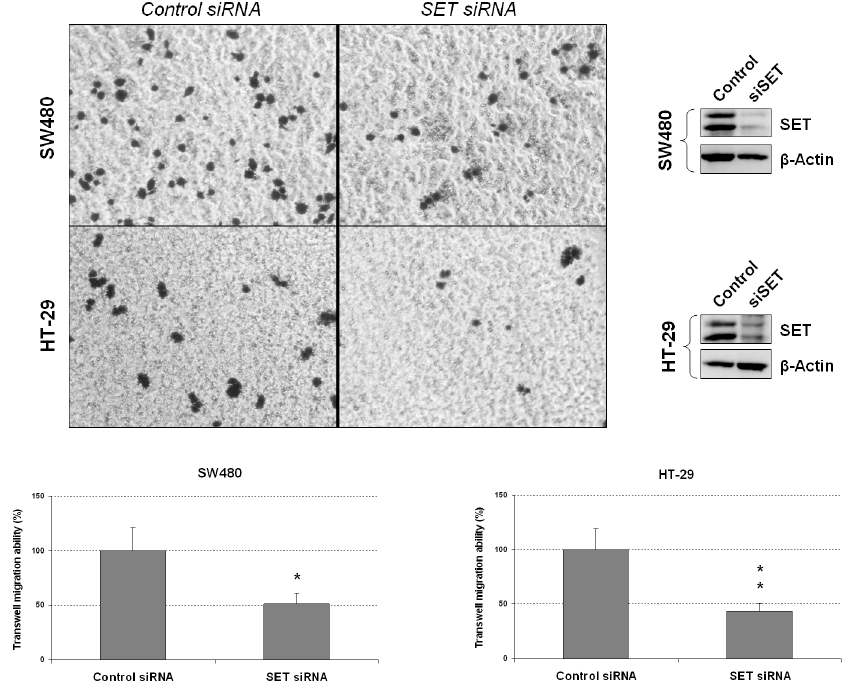
Figure 2. SET silencing inhibits transwell migration in CRC cells. Transwell migration assay in SW480 and HT ‐ 29 cells after SET silencing; * p < 0.05; ** p < 0.01.